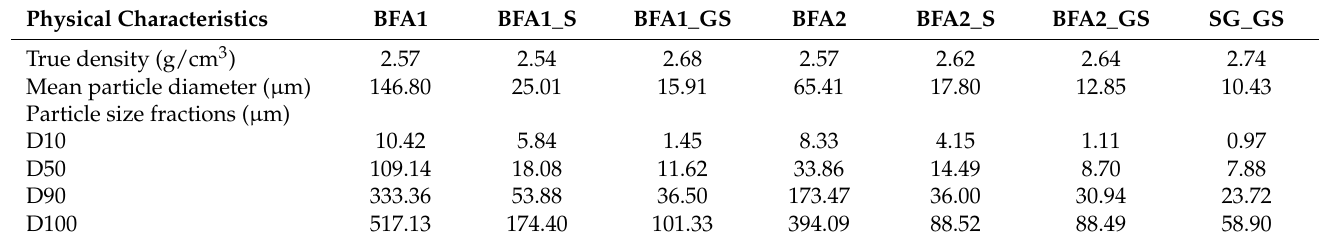
Table 2. Physical characteristics of ground SG, and BFA1 and BFA2 powders as received and pre-treated. Physical